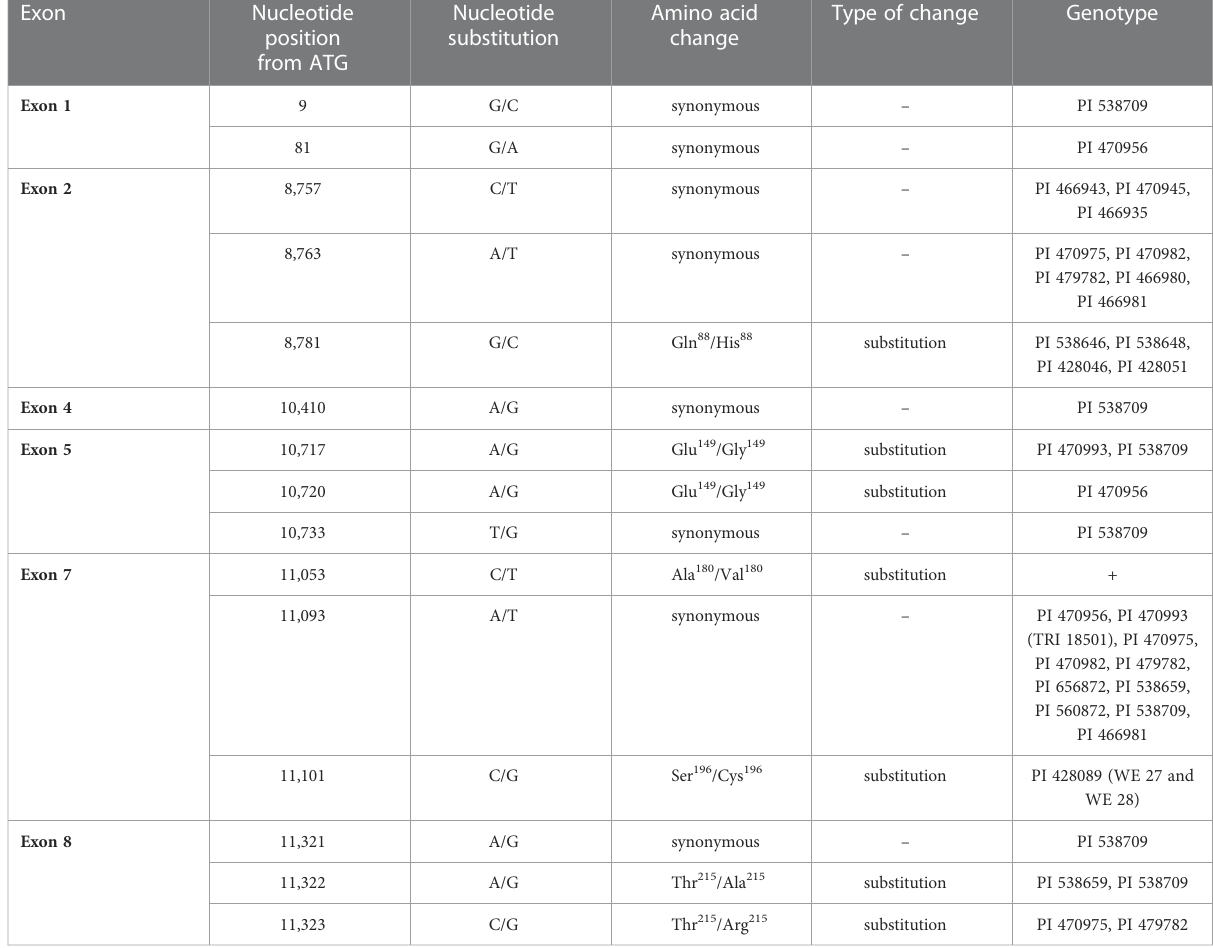
TABLE 1 Mutations within VRN-A1 exons. ´+´ group contains large number of genotypes (38) listed in the Supplementary Table 13 .